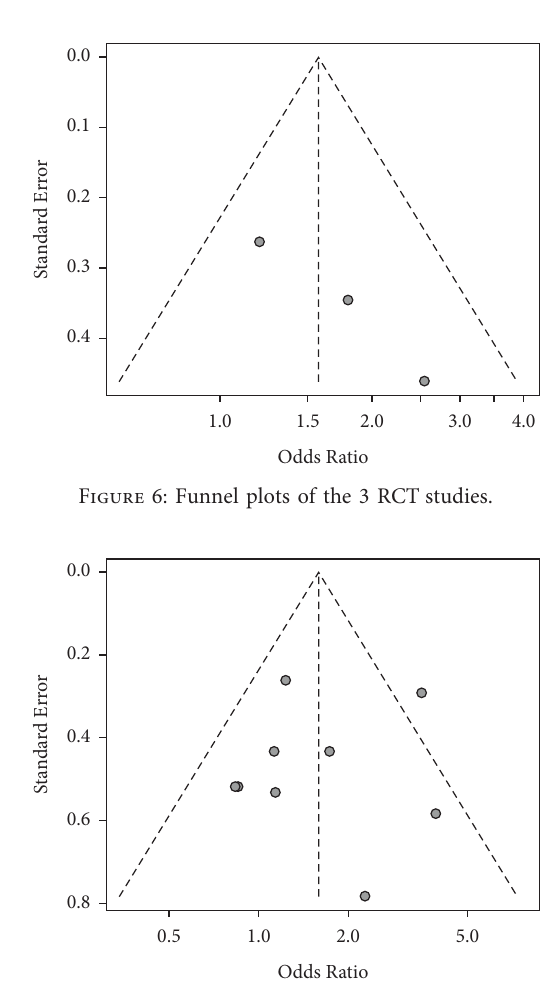
Figure 7: Funnel plots of the 8 RCS